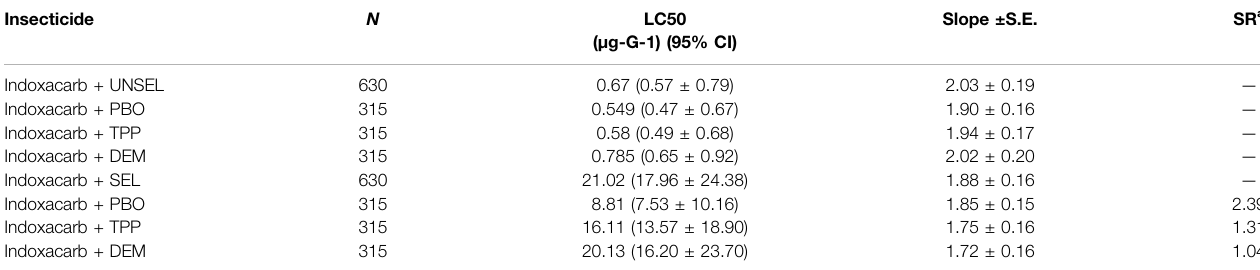
TABLE 3 | Synergism by PBO, TPP and DEM in indoxacarb-treated larvae of S. frugiperda . Insecticide